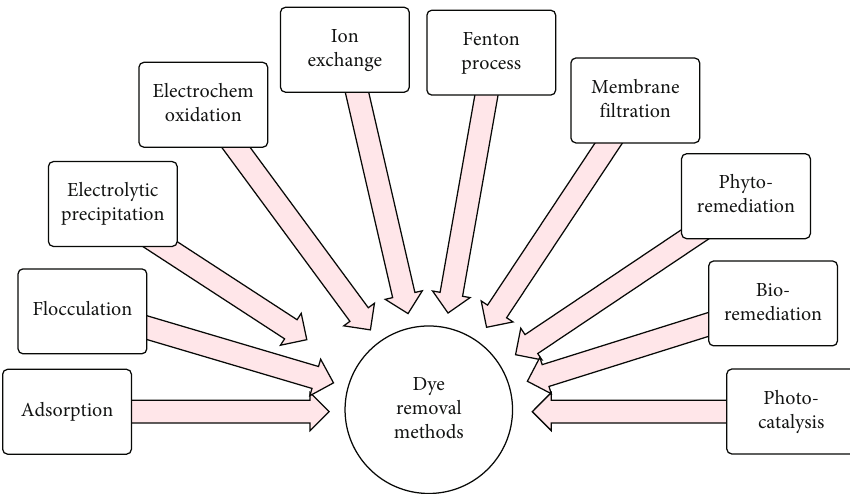
Figure 2: Degradation methods of dye e ffl uents.